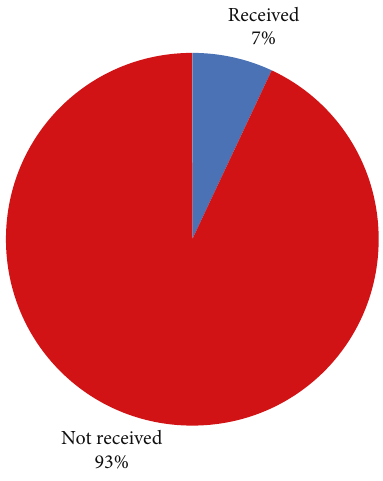
Figure 1: Food from any NGO within the past one